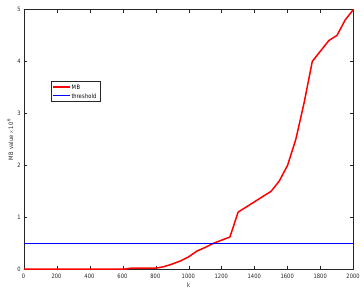
Figure 4. STUKF and MB -based detection for attenuation type fault.